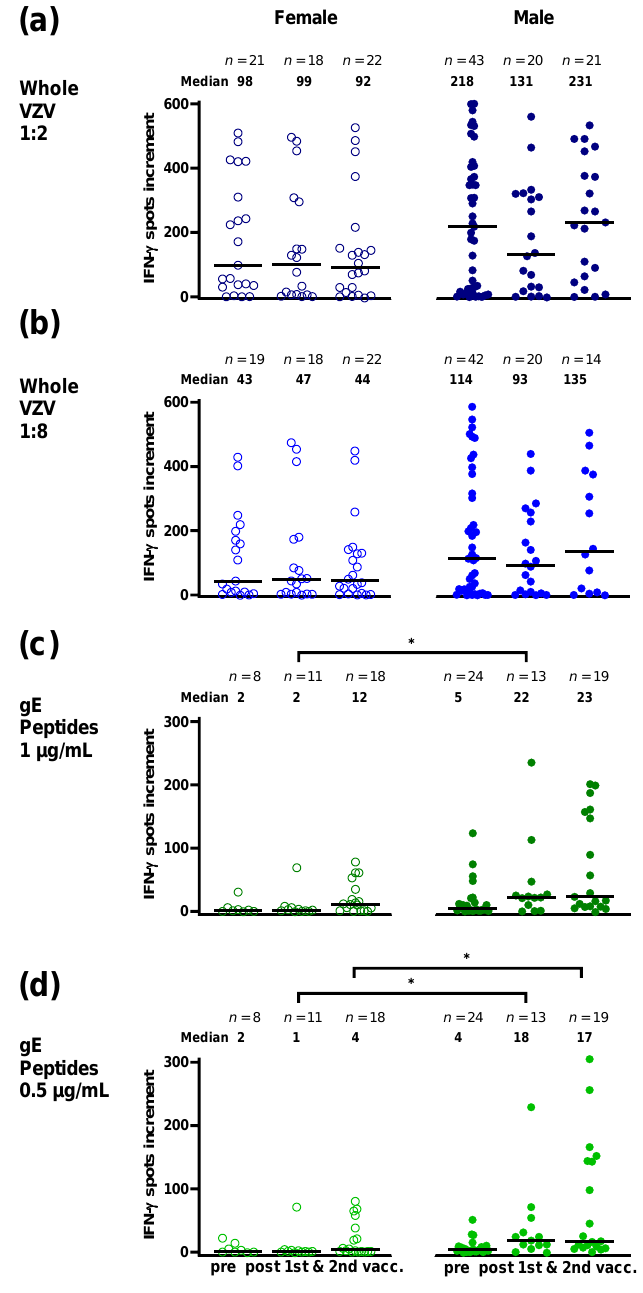
Figure 6. Varicella-zoster virus-specific ELISpot responses in female and male hematopoietic stem cell transplant recipients prior to and after the first and second vaccination with Shingrix™. Panel ( a ) displays responses to a whole VZV antigen (Behring), used at a dilution of 1:2, and panel ( b ) at a dilution of 1:8. Panel ( c ) displays responses to a peptide pool of glycoprotein E (gE) from JPT, used at concentration of 1 µ g/mL per peptide, in panel ( d ) at 0.5 µ g/mL. Open circles indicate females and filled circles males. In females and males blood sampling was performed at a median of 33 and 39 months after transplantation, respectively. In females the median interval between first vaccination and blood sampling was 53 days, and between second vaccination and blood sampling it was 84 days. In males, the respective intervals were 80 and 78 days. VZV-specific spots were determined as stimulated minus non-stimulated (background) values (spots increment). Horizontal lines represent median values. Data were compared by Mann–Whitney test (* p < 0.05).